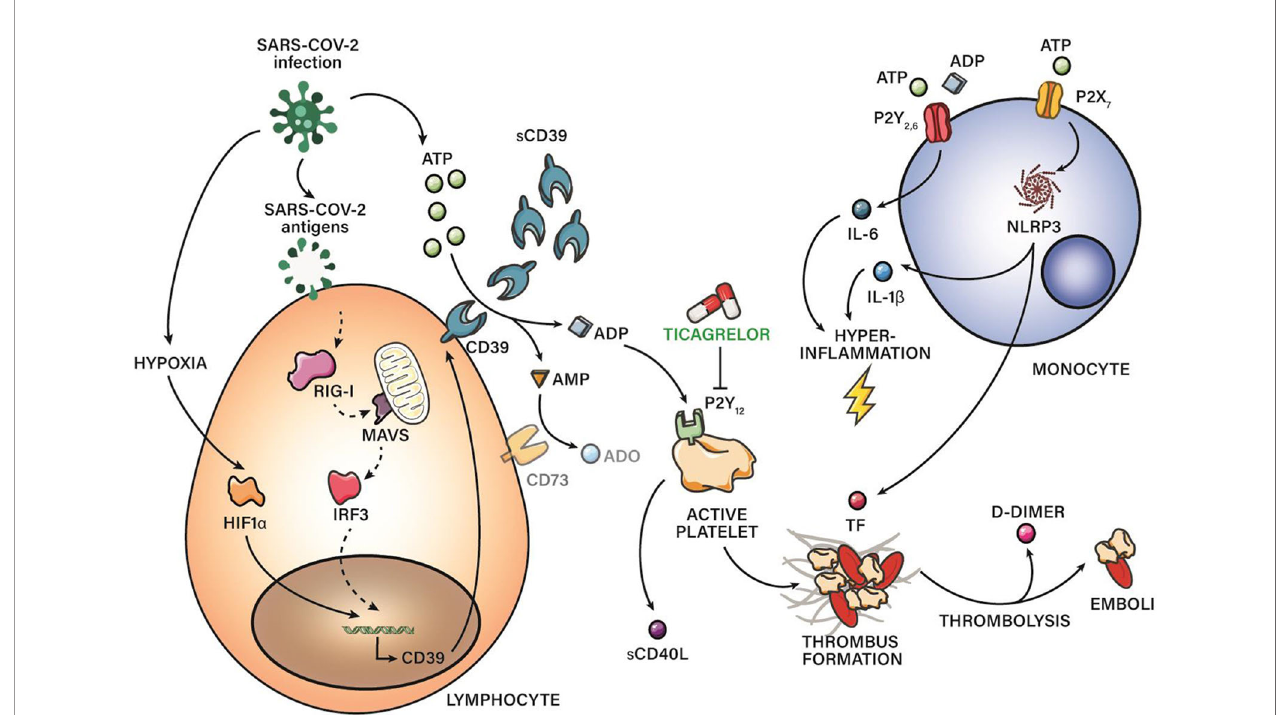
FIGURE 5 | CD39 in COVID ‐ 19 severity: schematic representation of pro-thrombotic and proin fl ammatory pathways related with purinergic signaling. sCD39 is upregulated along COVID-19 severity. Hypoxia and antiviral immune response through RIG-I pathway might be involved in CD39 upregulation. Moreover, this study reports impaired purinergic signaling in COVID-19, characterized by high levels of eATP and eADP in combination with low levels of anti-in fl ammatory ADO, maybe due to CD73 reduced expression. eATP contribute to hyperin fl ammation and TF release secondary to NLRP3 activation. eADP overproduction is linked to platelet activation through P2Y 12 R. Blockade of P2Y 12 R through drugs as ticagrelor is suggesting as a promising therapy for severe COVID ‐ 19